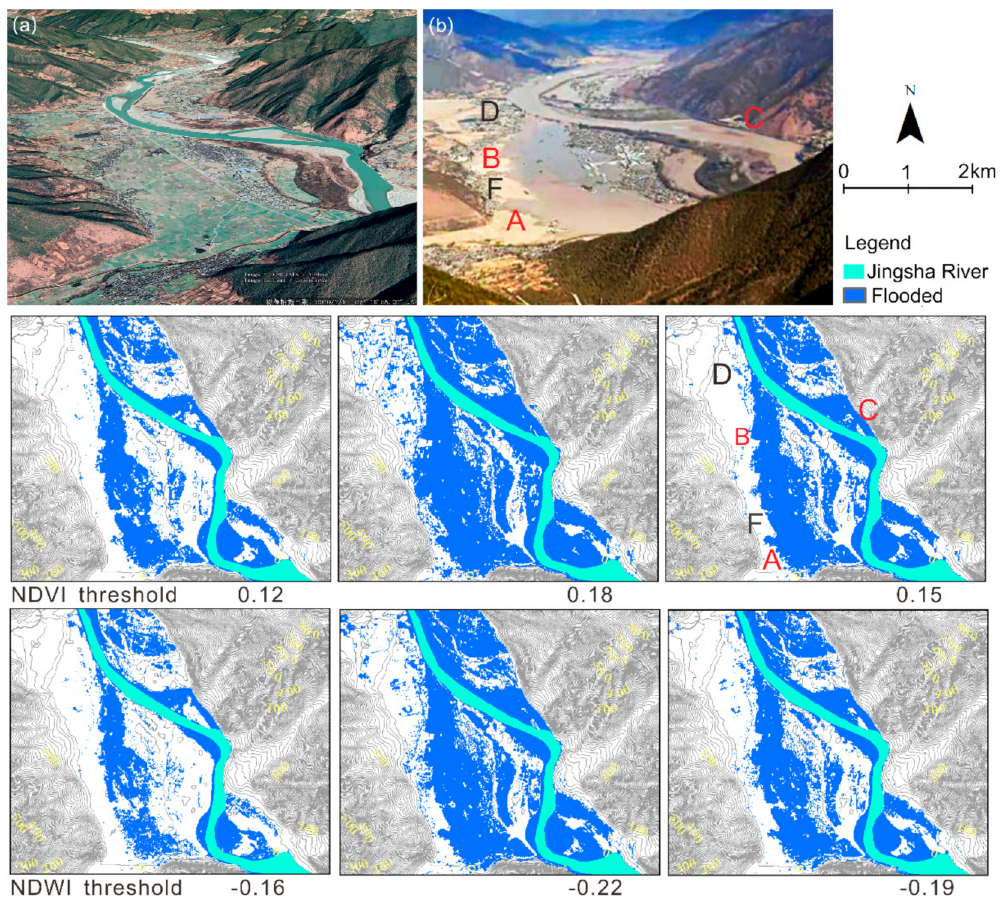
Figure 7. Flood mapping experiments obtained from applying NDVI (middle row) and NDWI (last row) to the test site in Ju Dian Town using Sentinel-2 images on 19 November 2018. ( a ) Google 3D view showing of the test site, ( b ) Flood transiting scene photos for 8:00 a.m., 15 November